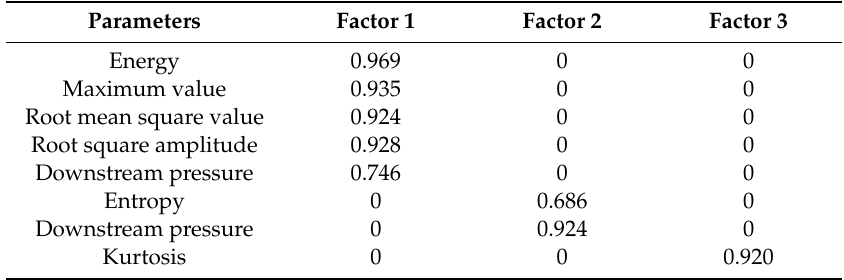
Table 3. Factorial load matrix after